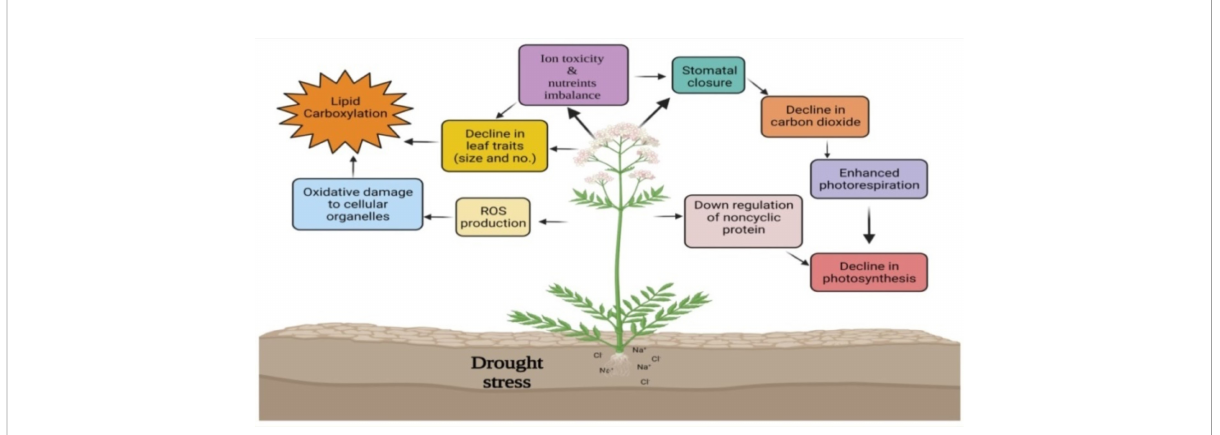
FIGURE 2 Effect of drought stress and the role of WRKY TFs in mitigating drought stress. Drought stress causes ROS production, oxidative damage, ion toxicity, and nutrient imbalance impairing plant growth and development. WRKY TFs regulate the expression of stress response genes and ROS scavenging enzymes. Overexpression of various WRKY TFs reduces ion loss and ROS accumulation, induces leaf stomatal mobility, decreases water loss rate thereby promote water retention, which overall improves phenotypic morphology and plant survival.